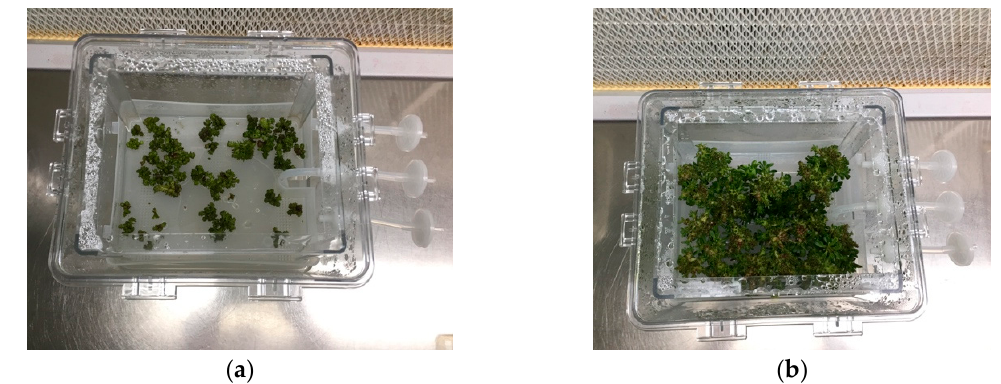
Figure 2. Explants of caper accessions “Sal 37” ( a ) and “Sal 39” ( b ) in a bioreactor after 60 days. Plants 2019 , 8 , x